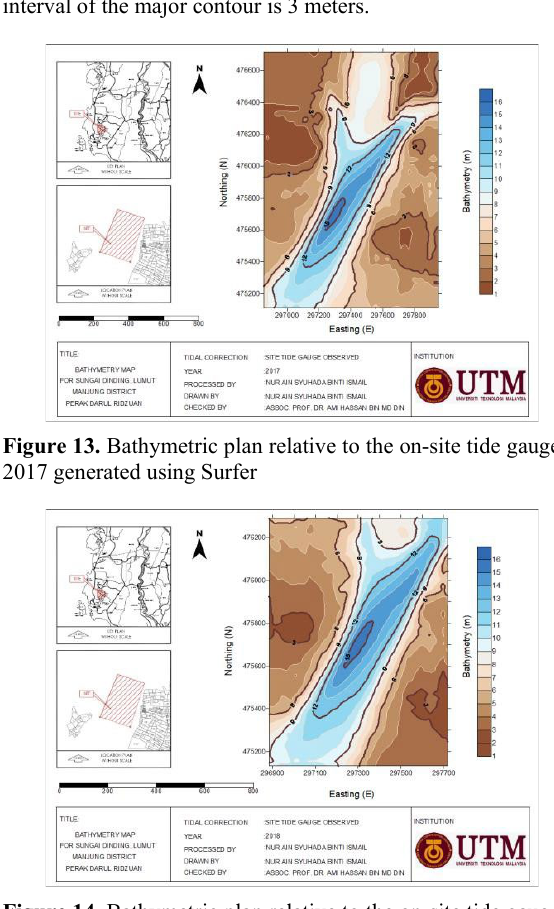
Figure 14. Bathymetric plan relative to the on-site tide gauge in 2018 generated using Surfer